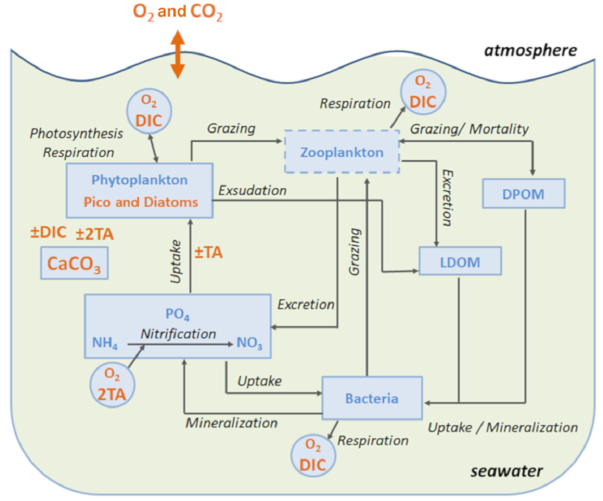
Figure 1. Schematic diagram of the biogeochemical model Eco3M- CarbOx. Explicit state variables of the model are indicated in continuous-line box or circles except the implicit variable for zooplankton (dotted line box). State variables written in orange are added variables compared to the preexisting biogeochemical model of Fraysse et al. (2013). Arrows represent processes be- tween two state variables. TA: total alkalinity; DIC: dissolved in- organic carbon; CO 2 : dissolved carbon dioxide; O 2 : dissolved oxy- gen; CaCO 3 : calcium